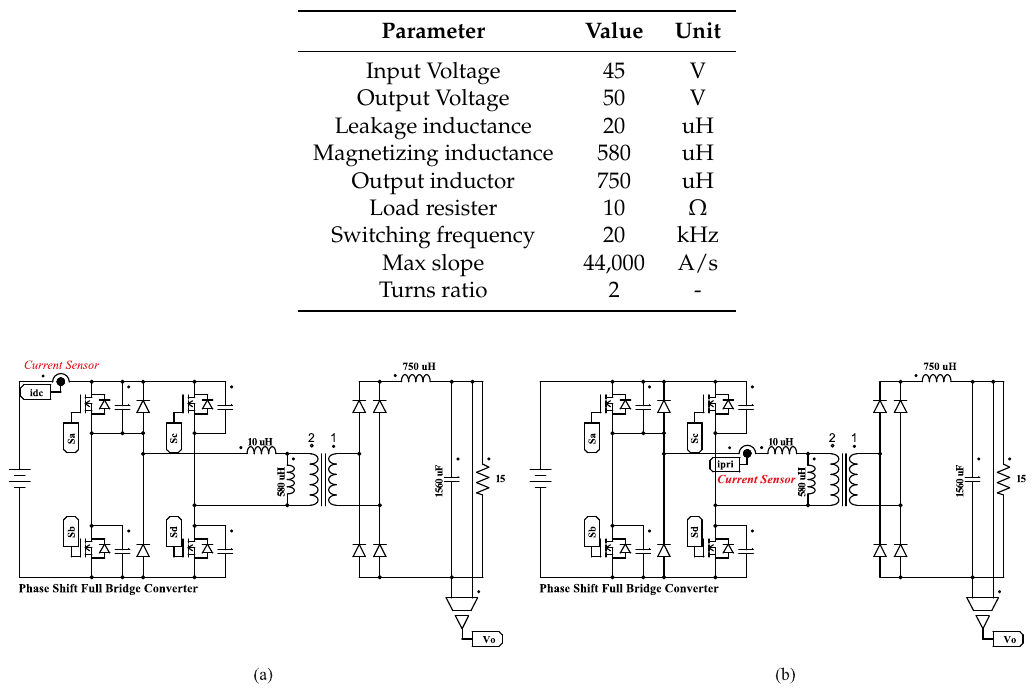
Table 1. Simulation using Powersim.